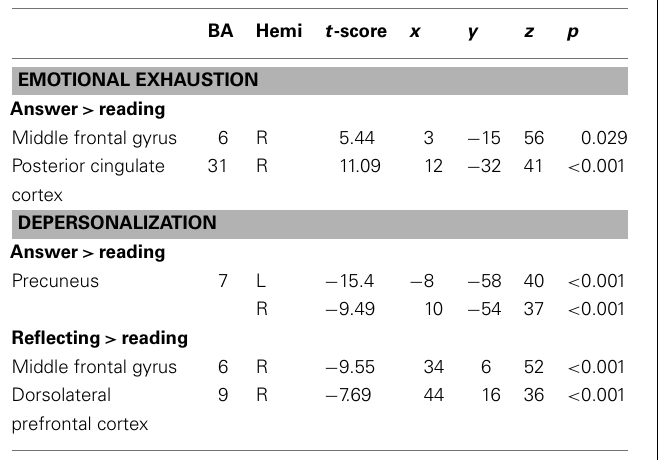
Table 2 | Covariate analysis results.